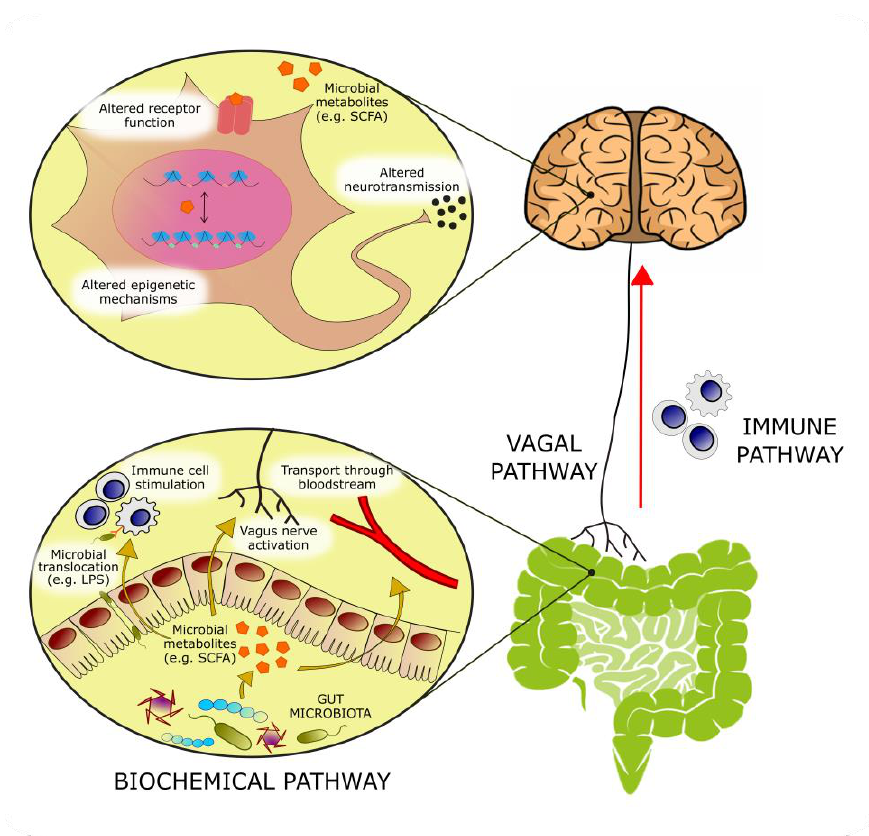
FIGURE 1: Bioactive molecules originating from microbial me- tabolism are thought to